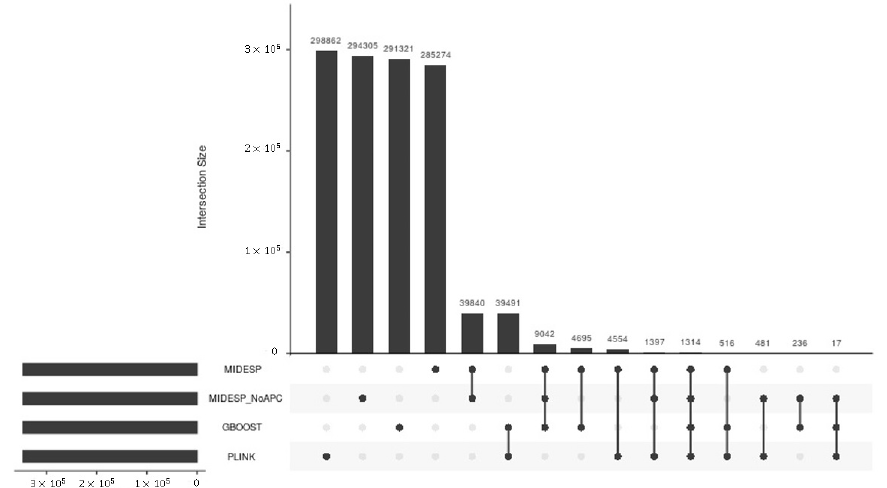
Figure 9. Number of epistatic SNP pairs detected for the BT dataset and their overlap between four methods represented in matrix layouts using the UpSet technique [121]. Black circles in the matrix layout indicate which methods are part of the